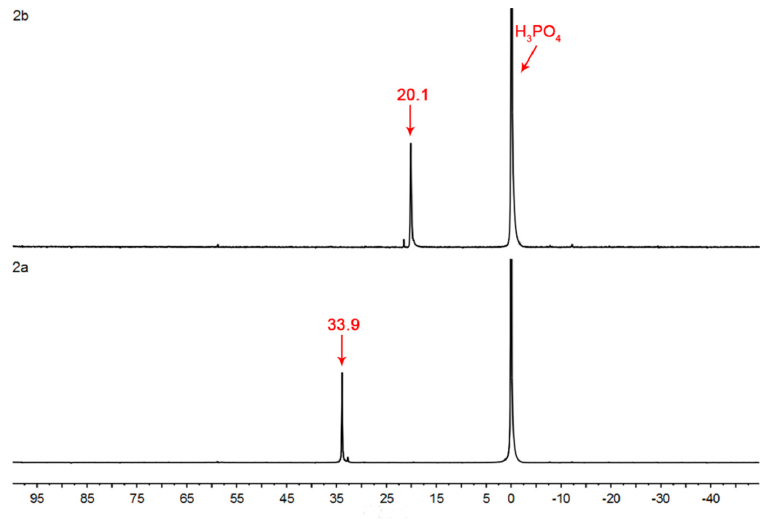
Figure 3. 31 P-NMR spectra of chitosan derivatives.